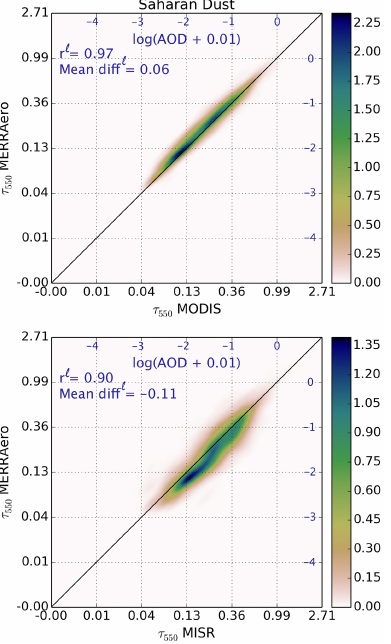
Figure 4. Comparison of 550nm MERRAero AOD to MODIS NNR (top) and MISR (bottom) retrievals over the Saharan dust re- gion for the period JJA 2007. r l and mean diff l are the correlation coefficient and the mean difference of the log-transformed AOD.